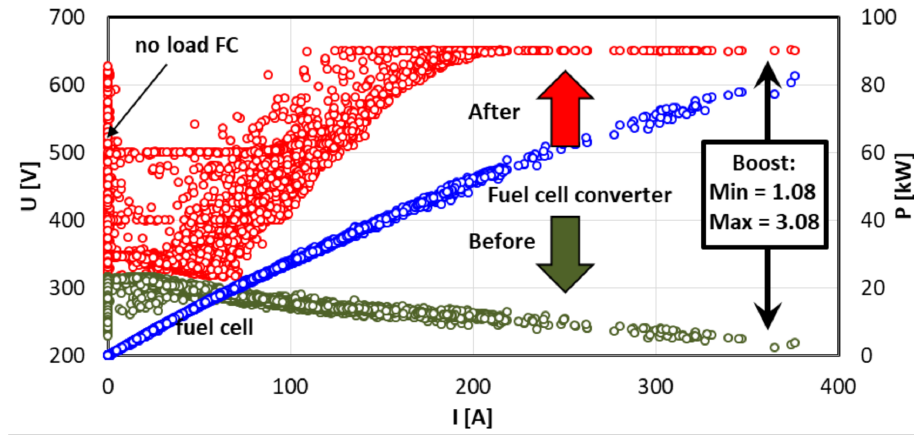
Figure 14. Current–voltage characteristics of a fuel cell and its voltage converter.